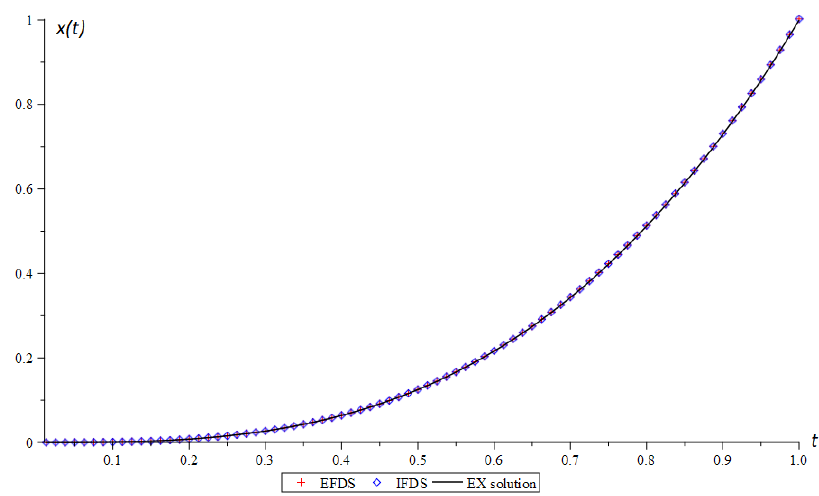
Figure 1. Solutions of the Cauchy problem (1) obtained from schemes (7) and (8), as well as the exact solution (12).